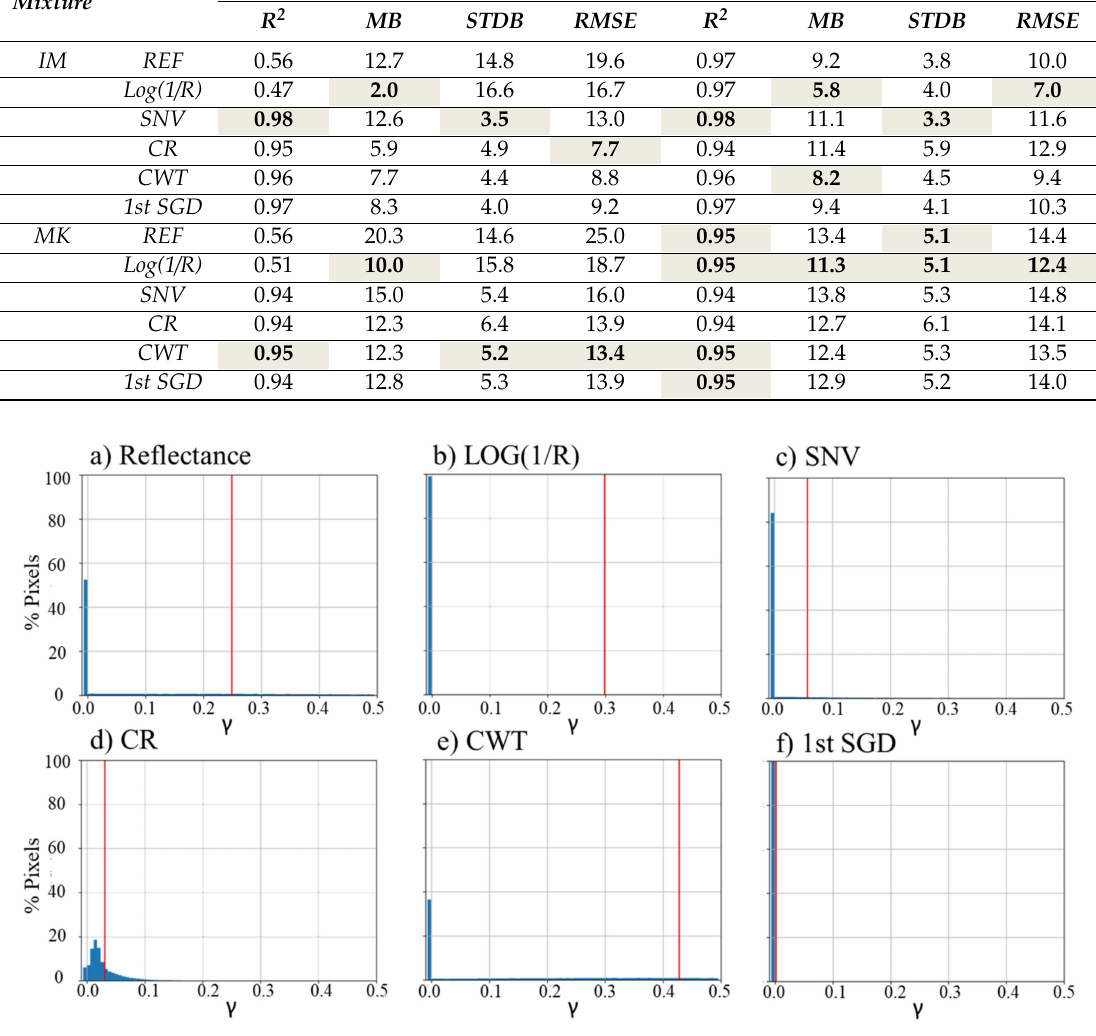
Figure 10. Histograms of parameter γ (non-linearity contribution of the generalized bilinear model (GBM)) for MK mixtures: ( a ) reflectance data, ( b – d ) for each spectral preprocessing (red: average value of γ